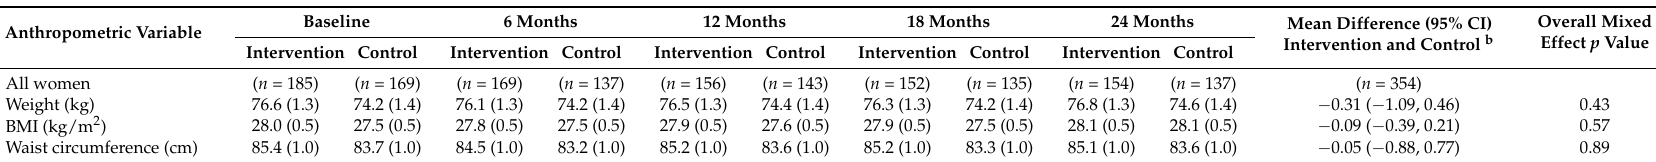
Table 4. Anthropometric data (means and standard errors a ) for all midlife women participating in a weight gain prevention study and by subgroup in the intervention and control groups over